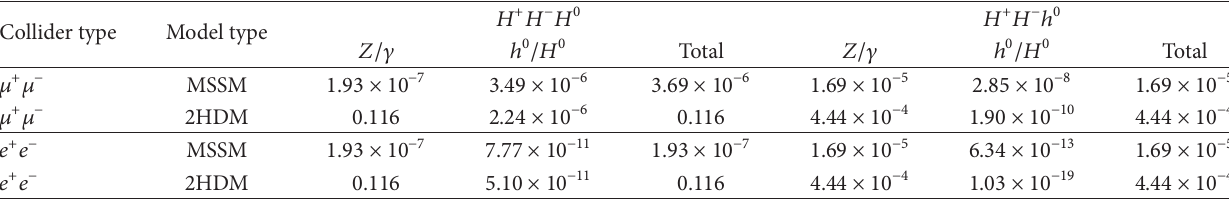
Table 2: Total cross section (in fb) comparison between electron-positron and muon-muon colliders as well as among MSSM and 2HDM at √𝑠 = 1.5 TeV. Collider type